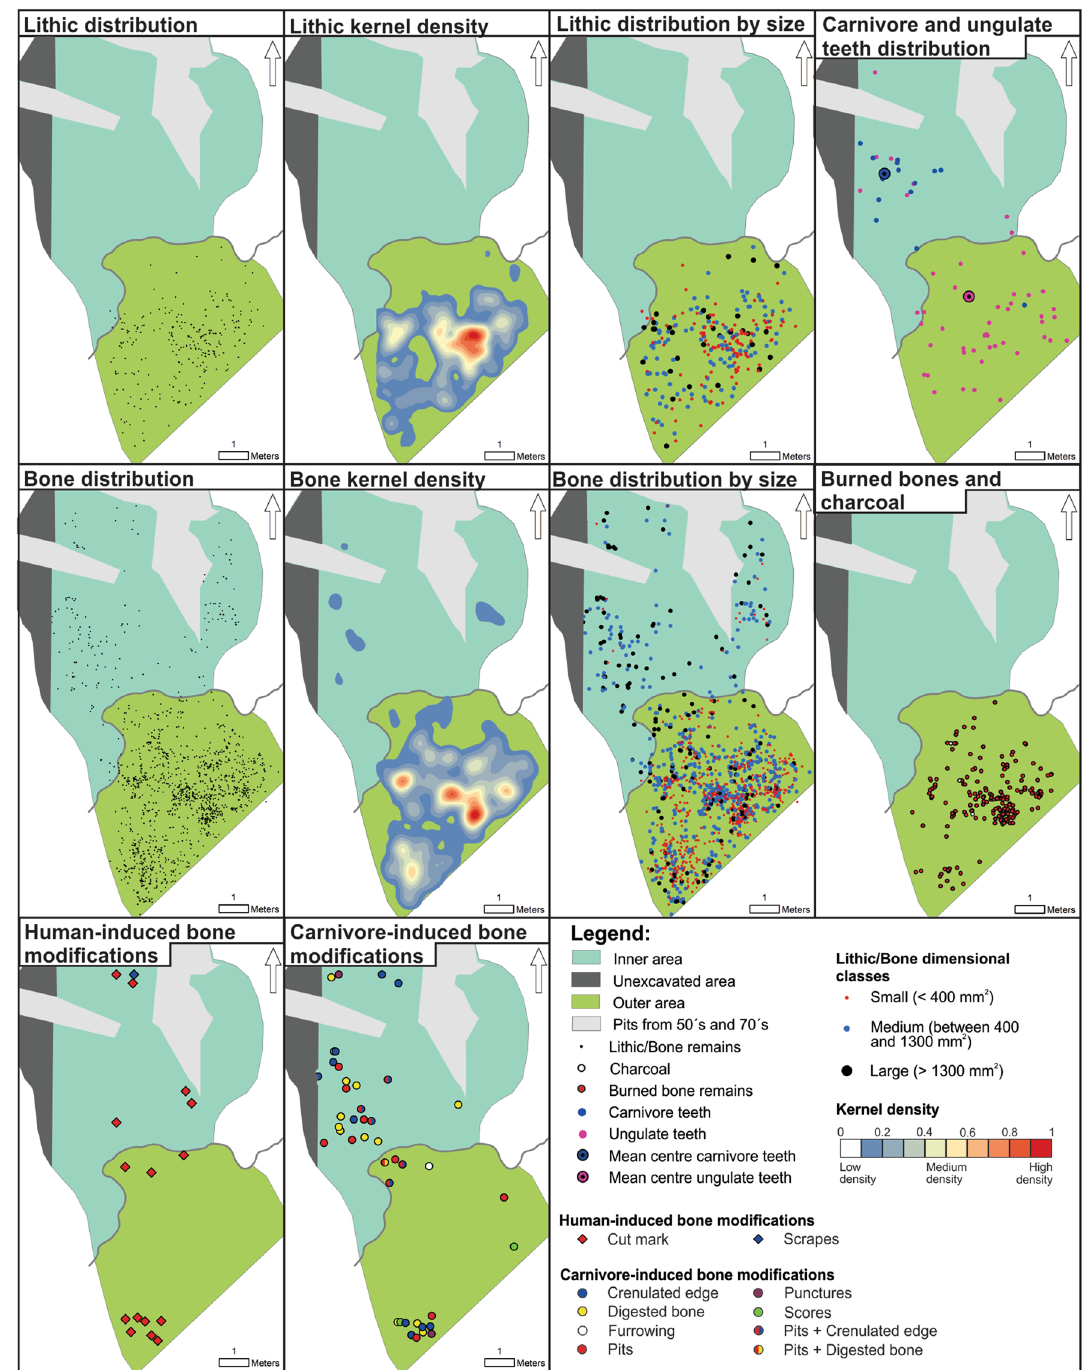
Figure 7. Spatial distribution of lithic artefacts, faunal specimens, burned bones, charcoal, carnivore/ungulate teeth, and human/carnivore-induce modifications on bones from subunit